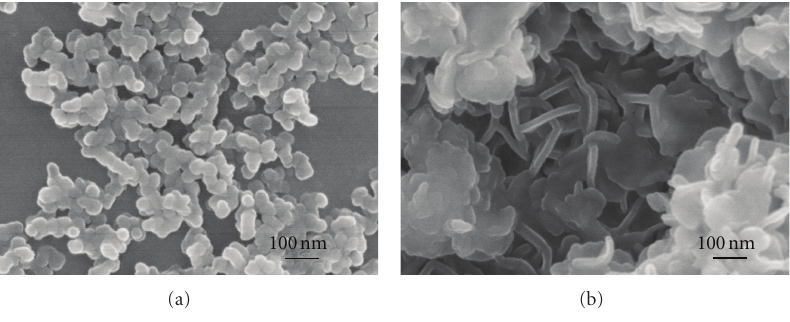
Figure 3: SEM images of (a) LDH and (b) FLDH.